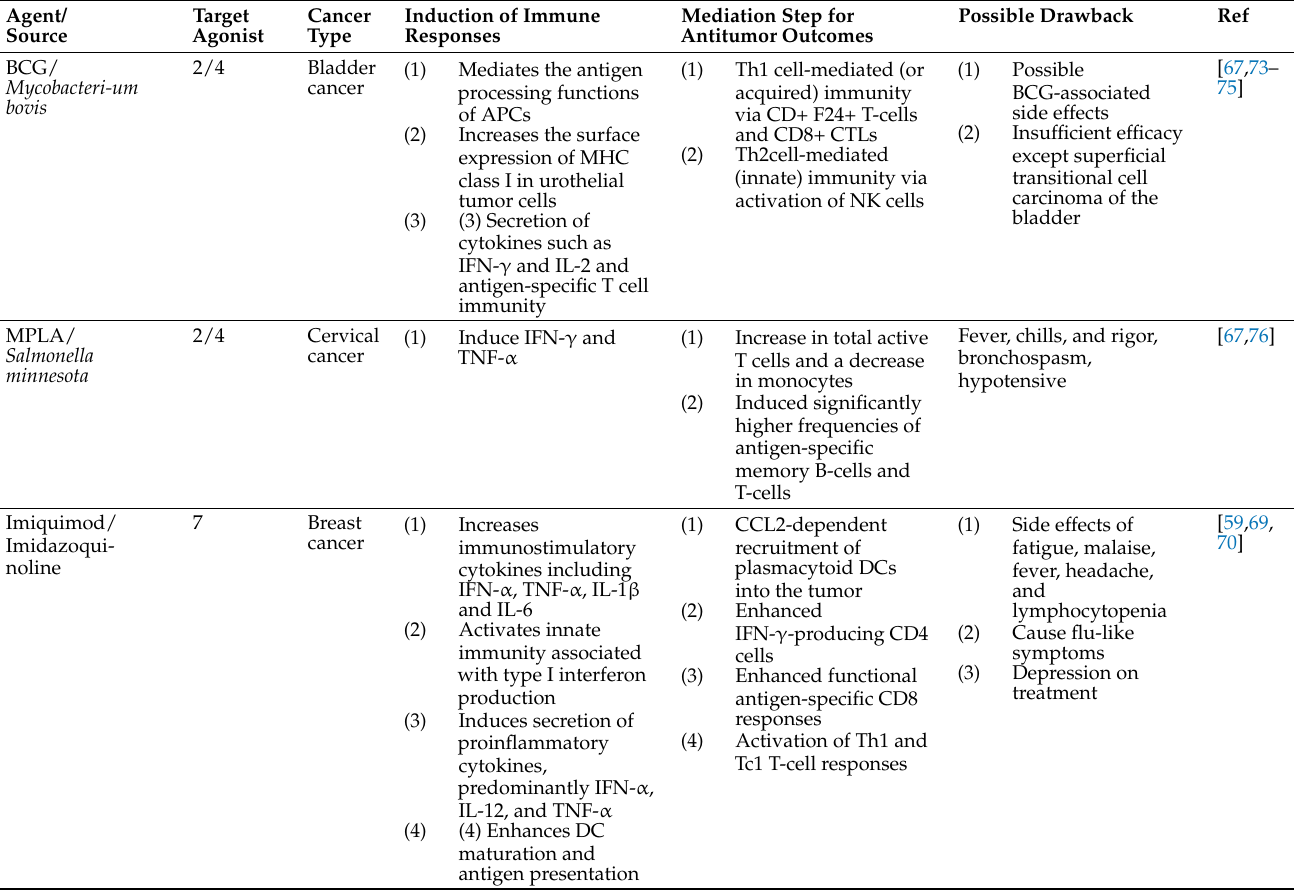
Table 2. Representative FDA-approved TLR agonists for cancer